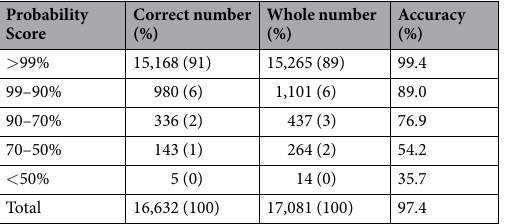
Table 1. The distribution of the probability score and the accuracy of the CNN